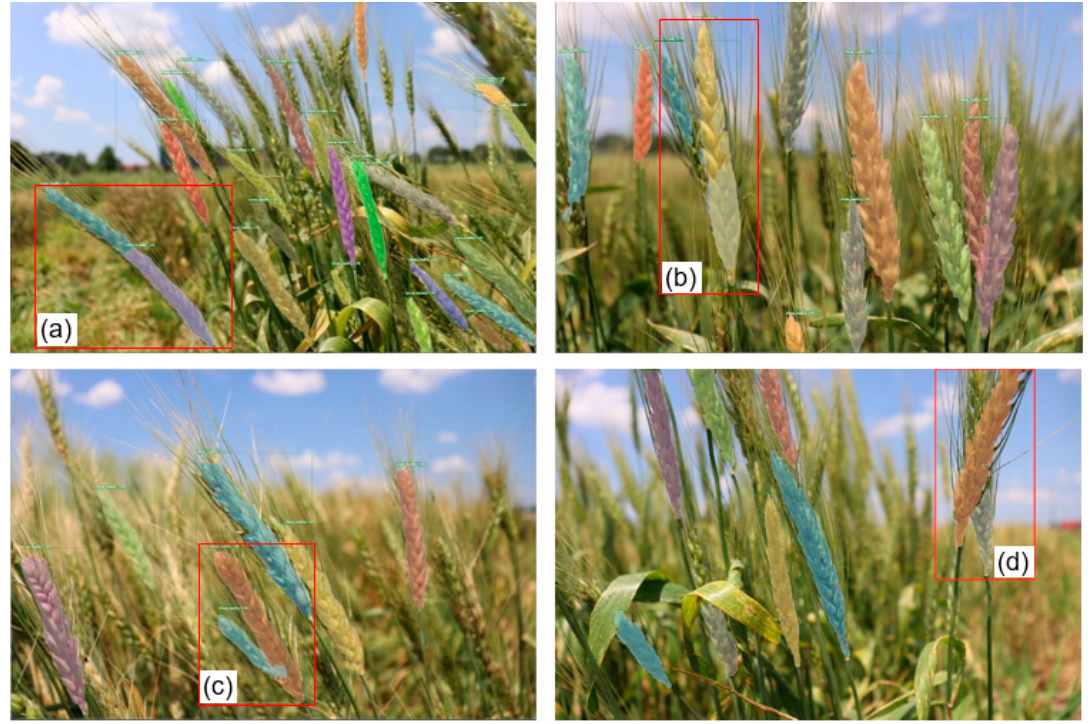
Figure 7. Results of instance segmentation of selected wheat spikes (red rectangles); ( a , b ) examples of multi-detections; ( c , d ) examples of wheat spike occlusion.